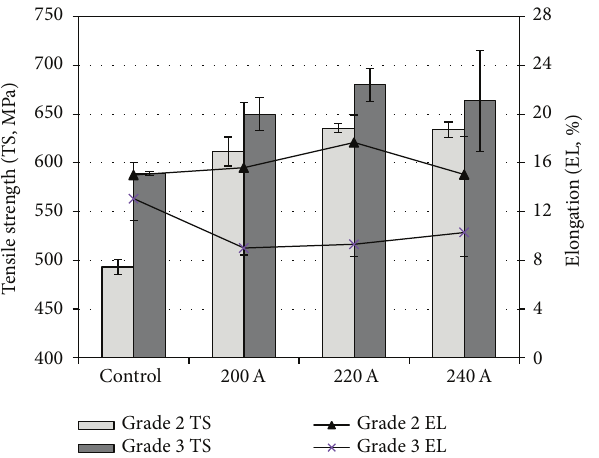
Figure 4: Tensile strengths and elongations of control specimens (grades 2 and 3) and specimens laser-treated with two different spot diameters (1.0mm and 1.6mm) at a constant emission current of 200 A and a pulse duration